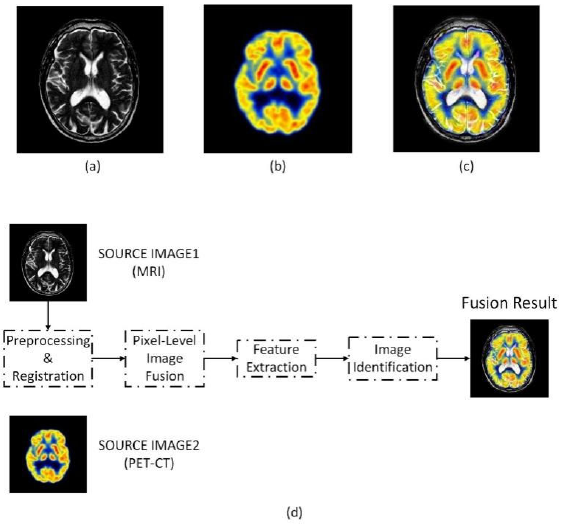
Figure 3. ( a ) T2-weighted MRI image. ( b ) PET image. ( c ) Fusion result of pixel-level fusion method. ( d ) Pixel-level image fusion flow